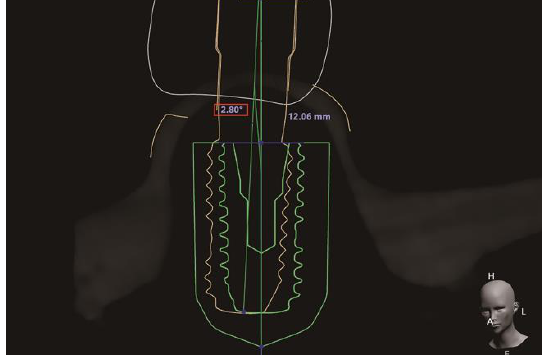
Figure 3. Representative image of the measurement method of the preoperative and postoperative angular deviation of the implant using the implant planning software program (Implant Studio version 1.7.3.2, 3Shape A/S, Copenhagen, Denmark). The green line indicates the contour of the implant in the preoperative stage, whereas the yellow line indicates the postoperative contour.